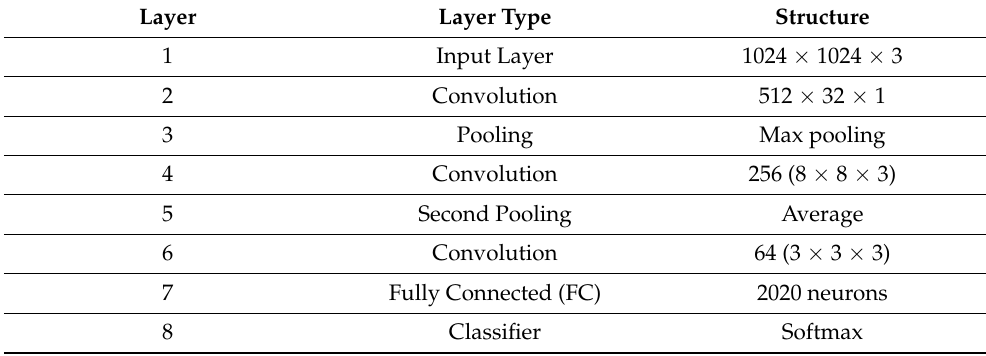
Table 4. Experiments Configuration of the neural network with the structure of the CNN layers.